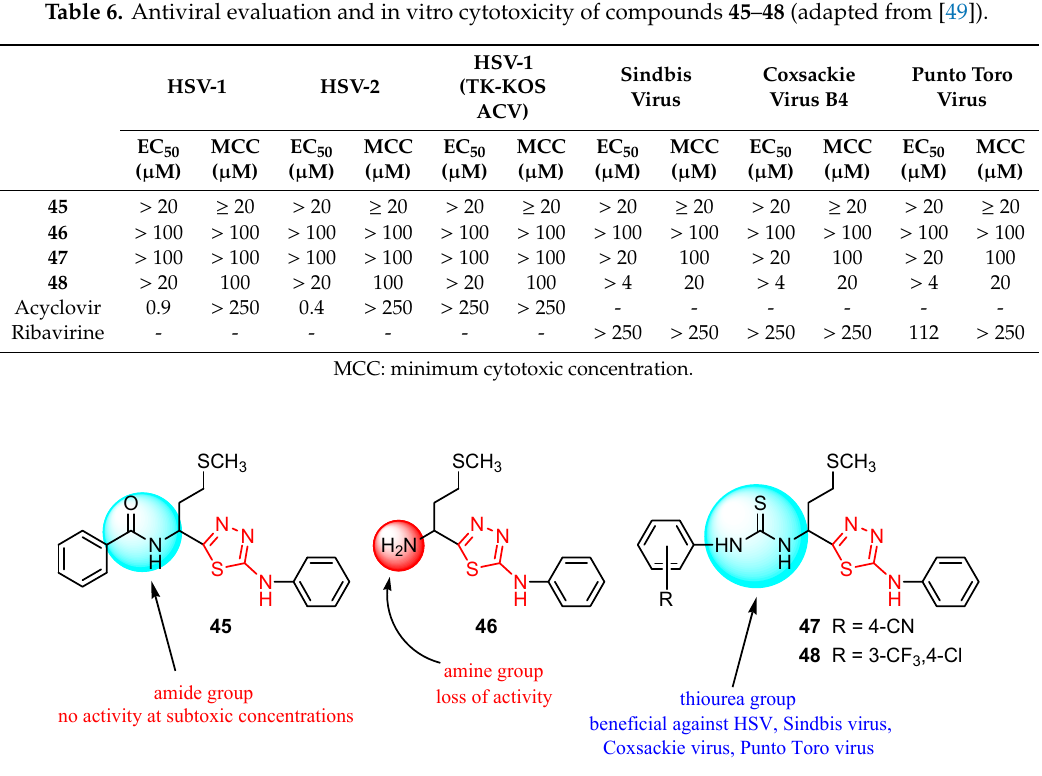
Figure 7. The influence of substituents of 1,3,4-thiadiazole derivatives 45 – 48 on antiviral activity. 2-Amino-5-(2-sulphamoylphenyl)-1,3,4-thiadiazole 56 reduced the replication of some DNA